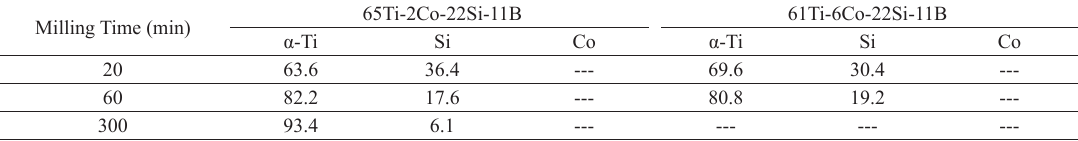
Table 1. Relative phase amounts determined by Rietveld refining in 65Ti-2Co-22Si-11B and 61Ti-6Co-22Si-11B powders milled at different times. Milling Time (min)